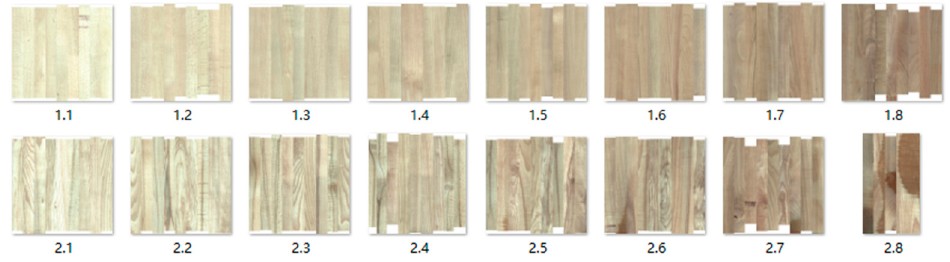
Figure 12. Two ‐ clustering result images. Figure 12. Two-clustering result